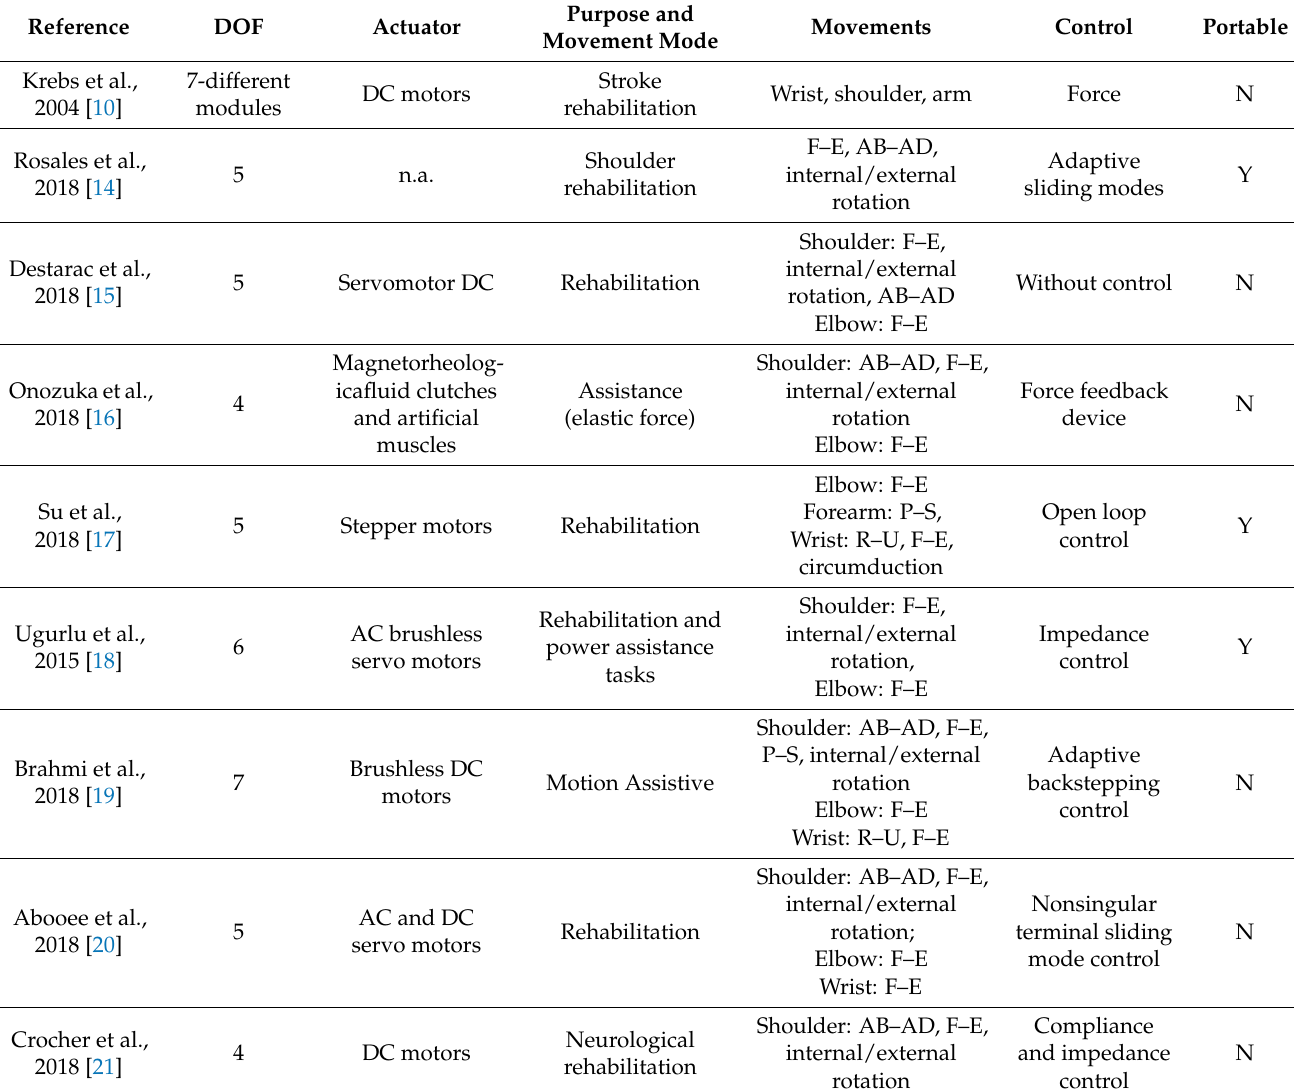
Table 1. Upper limb exoskeletons for rehabilitation and